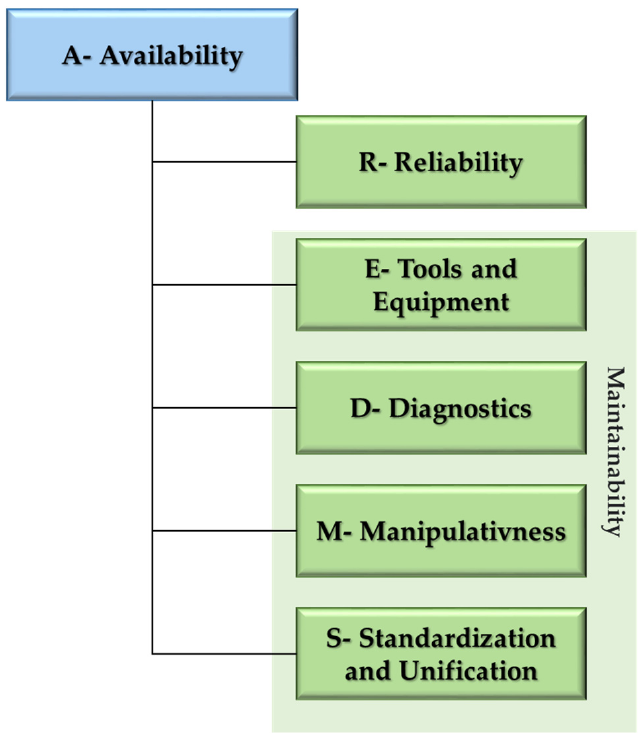
Figure 10. Partial indicators of the availability of continuous systems.